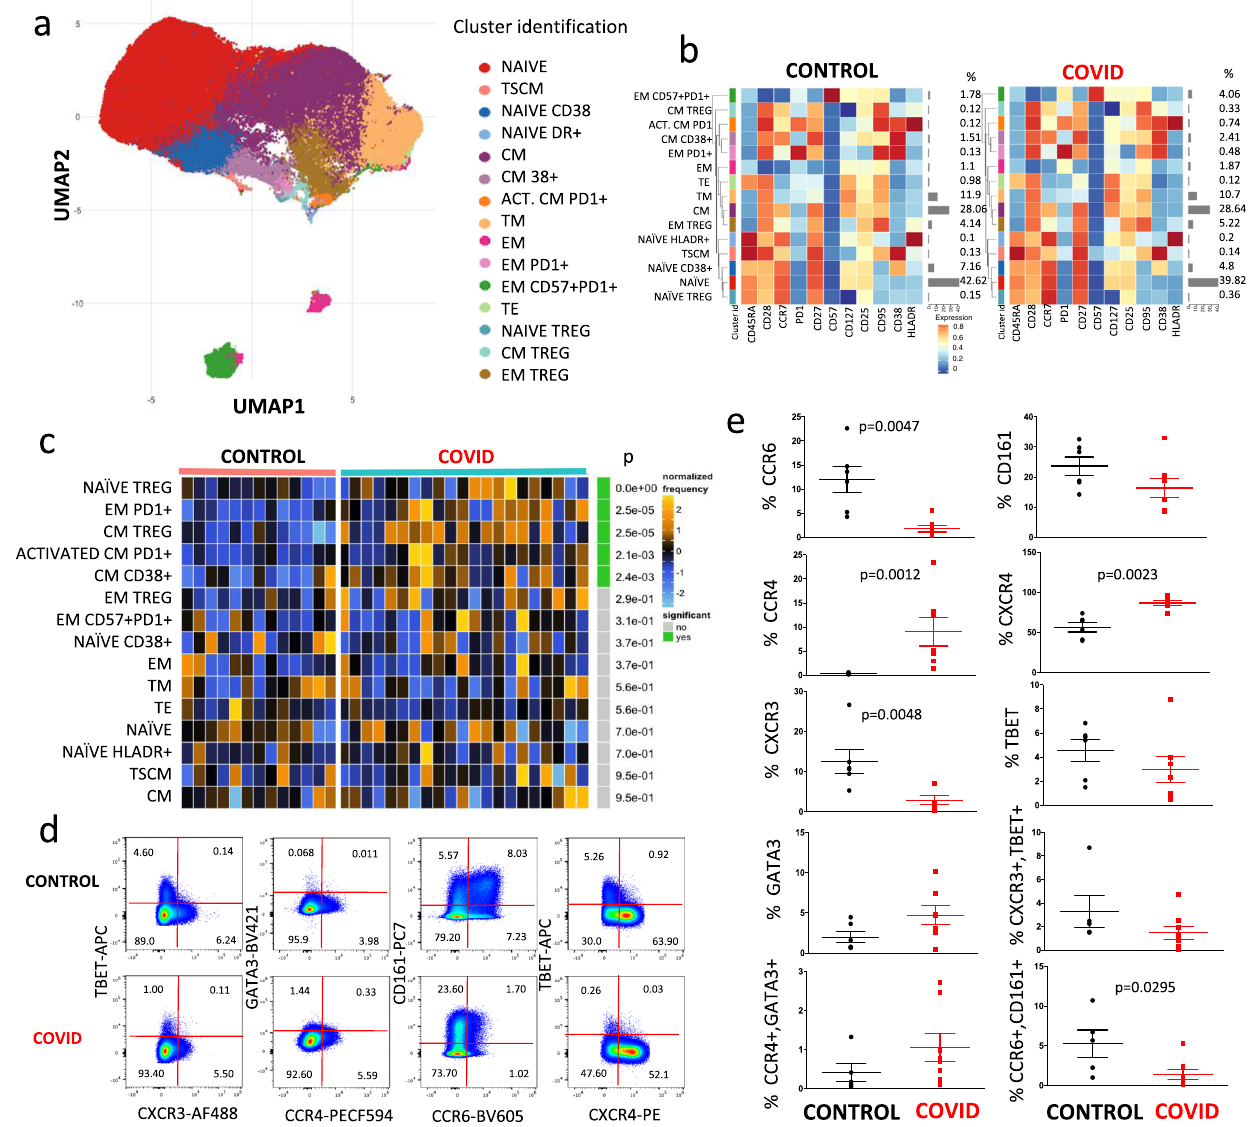
Fig. 2 Unsupervised analysis of CD4 + T cells and their characterization. a Uniform Manifold Approximation and Projection (UMAP) representation of the CD4 + T cell landscape. b Heat map representing different CD4 + T cell clusters identi fi ed by FlowSOM, with relative identity and percentages in healthy controls and COVID-19 patients. The colors in the heat map represent the median of the arcsinh, 0 – 1 transformed marker expression calculated over cells from all the samples, varying from blue for lower expression to red for higher expression. The dendrogram on the left represents the hierarchical similarity between the metaclusters (metric: Euclidean distance; linkage: average). Each cluster has a unique color assigned (bar on the left). Barplot along the rows (clusters) and values on the right indicate the relative sizes of clusters. c Differential analysis between controls (bar color: salmon; n = 13) and COVID-19 (emerald; n = 21). The heat represents arcsine-square-root transformed cell frequencies that were subsequently normalized per cluster (rows) to mean of zero and standard deviation of one. The color of the heat varies from blue indicating relative under-representation to orange indicating relative over- representation. Bar and numbers at the right indicate signi fi cant differentially abundant clusters (green) and adjusted p values. Clusters are sorted according to adjusted p values, so that the cluster at the top shows the most signi fi cant abundance changes between the two conditions. d Representative dot plots related to the expression of different chemokine receptors and lineage-specifying transcription factors in gated CD4 + T from a control (upper) and a patient (lower panel). Numbers indicate the percentage in each quadrant. Two experiments (one for the control group, one for patients) out of 13 are shown. Numbers indicate the percentage in each quadrant. The gating strategy for the identi fi cation of CD4 + T cells is reported in Supplementary Fig. 1. e Percentages of different CD4 + T cell subpopulations in controls ( n = 6) and patients ( n = 7), obtained by manual gating. Data represent individual values (dots), mean (centre bar) ± SEM (upper and lower bars). Statistical analysis is performed by two-sided Mann – Whitney nonparametric test; if not indicated, p value is not signi fi cant. Source data are provided as a Source Data fi